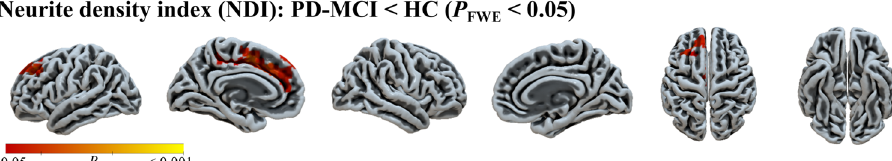
Fig. 2 NDI comparisons among groups. Compared with HC, only PD-MCI patients showed reduced NDI predominantly in left frontal area, left cingulate and paracingulate gyri. HC healthy control, NDI neurite density index, PD-MCI Parkinson ’ s disease with mild cognitive positively correlated with the MoCA scores ( r = 0.440, P < 0.001) (Fig. 3a) and the memory performance of detailed neuropsycho- logical tests ( r = 0.333, P = 0.004) (Fig. 3b) in the whole PD patients, but not correlated with other speci fi c cognitive domains (all p > 0.05). For MoCA subcategory domains, the ODI values were signi fi cantly positively correlated with the executive function, visuospatial ability, memory scores of the MoCA subcategory in the whole PD patients ( r = 0.338, P = 0.003; r = 0.386, P = 0.001; r = 0.354, P = 0.002, respectively). There was no signi fi cant